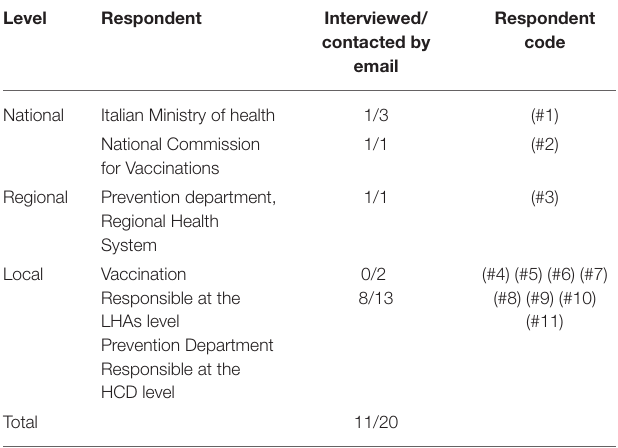
TABLE 1 | List of stakeholders